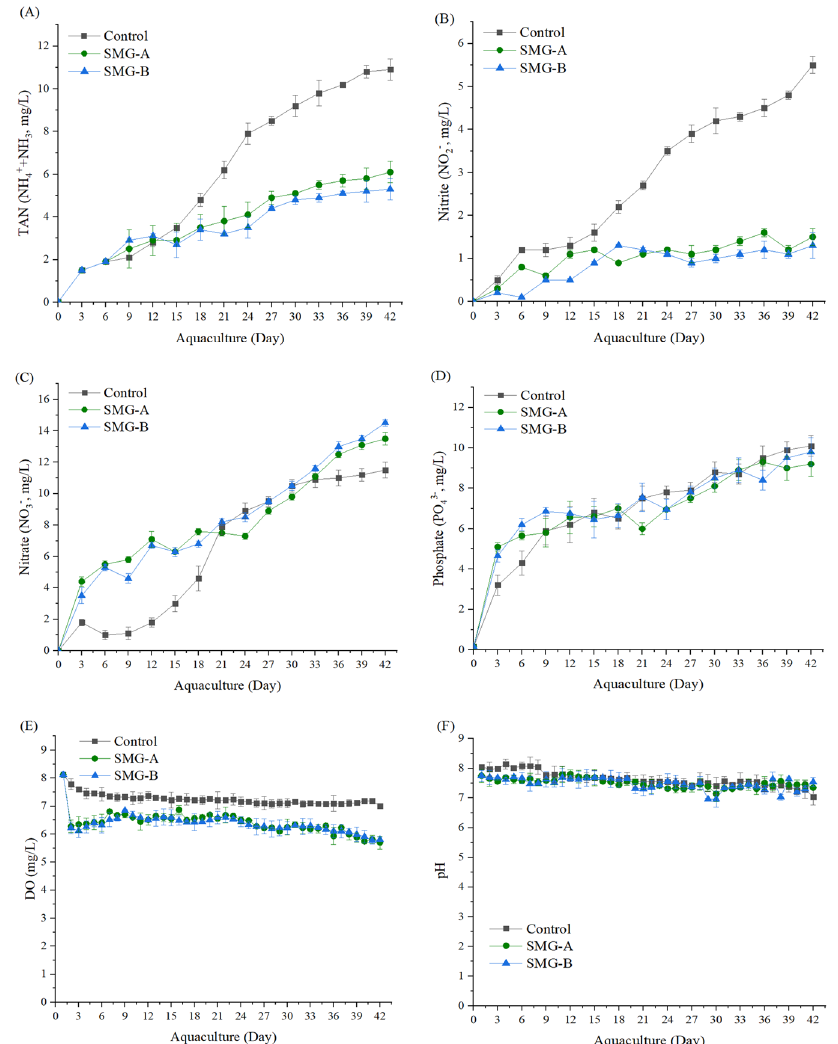
Figure 2. Change patterns of ( A ) TAN (NH 4+ and NH 3 ), ( B ) nitrite (NO 2 − ), ( C ) nitrate (NO 3 − ), ( D ) Phosphate (PO 43 − ), ( E ) DO, and ( F ) pH concentrations experimental tanks during the 6-week study period. The data points represent the treatment means and the error bars represent the standard error of the mean